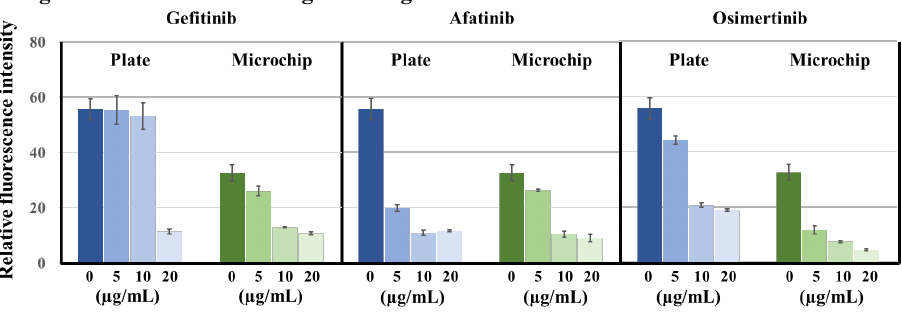
Figure 4. Drug evaluation of EGFR-targeted drugs. Effects of different concentrations of gefitinib, afatinib, and osimertinib on HCI-H1650 cells using a 2D well plate and 3D lung-on-a-chip methods. n = 3.